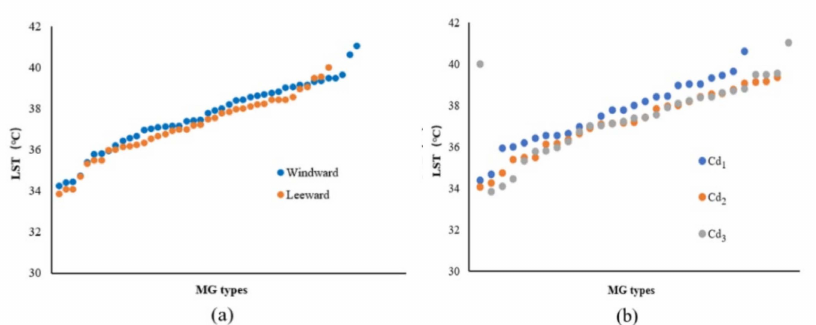
Figure 9. ( a ) Scatter plot of LST values corresponding to the MG types of green space in different locations (leeward or windward) in the Width-I river zone according to the increasing LST. ( b ) LST values corresponding to the MG types of green space in different Cd grades in the Width-I river zone according to the increasing